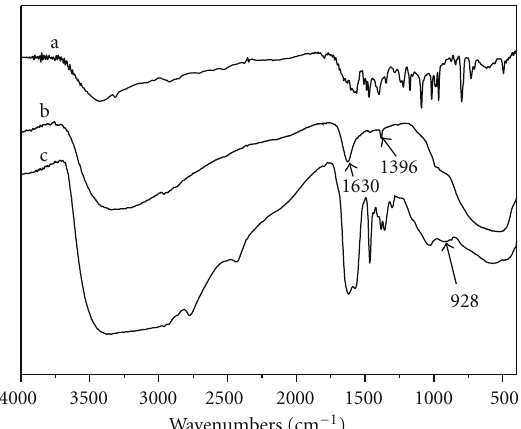
Figure 2: UV-vis DRS spectra of TiO 2 (a) APTMPP-MPS-TiO 2 (b). by the condensation reaction of APTMPP-MPS and TiO 2 microspheres.